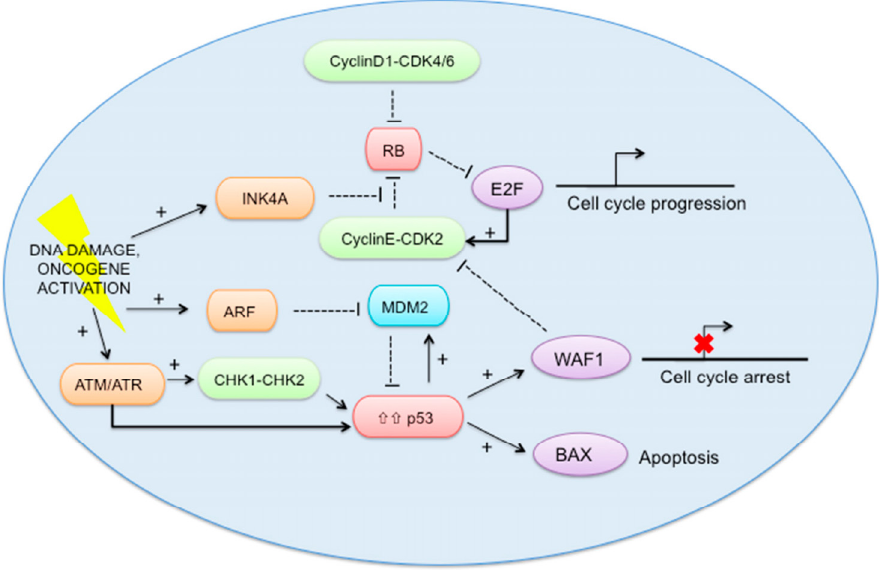
Figure 3. The pathways regulating cell cycle arrest [37]. Figure licensed under a CC BY 4.0 license.